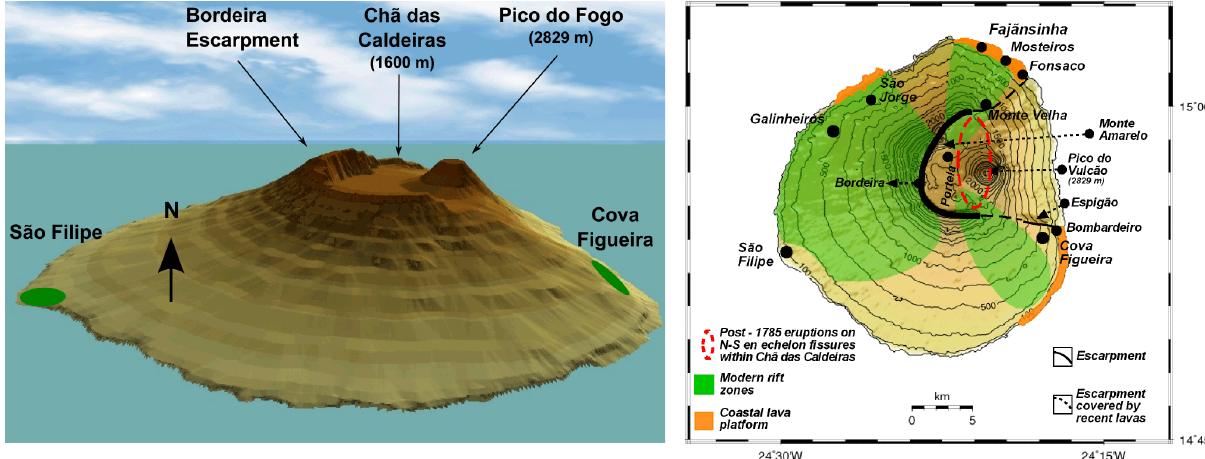
Fig. 2. Main geomorphological and structural features of Fogo. (Left) Perspective view from the south. (Right) Topographic map of Fogo (SRTM model), also showing the modern rift zones; contour lines are in metres. Adapted from Day et al. (1999) and Fonseca et al.